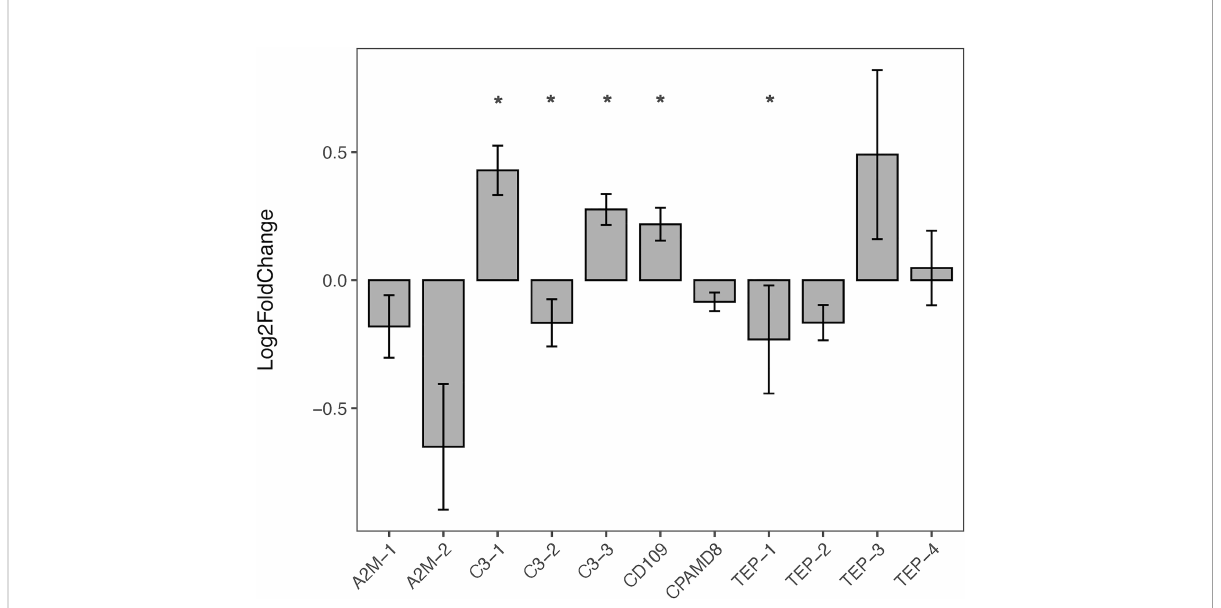
FIGURE 4 Constitutive Expression of TEPs in B. glabrata . The expression of the various TEP transcripts was measured via qRT-PCR in resistant BS90 snails (gray bars) and compared to susceptible NMRI snails (baseline) under control (no treatment) conditions. TEPs gene expression was normalized to the reference gene, RPS19 ( D CT = CT target – CT reference ). To compare the differences in constitutive TEPs gene expression between BS90 and NMRI snail strains, log-transformed expression levels of BS90 control snails were calculated relative to NMRI control snails using the Pfaf fl comparative method (across all time points; n=27). Statistical analysis was performed using the non-parametric Mann-Whitney test due to non- normal distribution of the data.* Indicates signi fi cant difference (p ≤